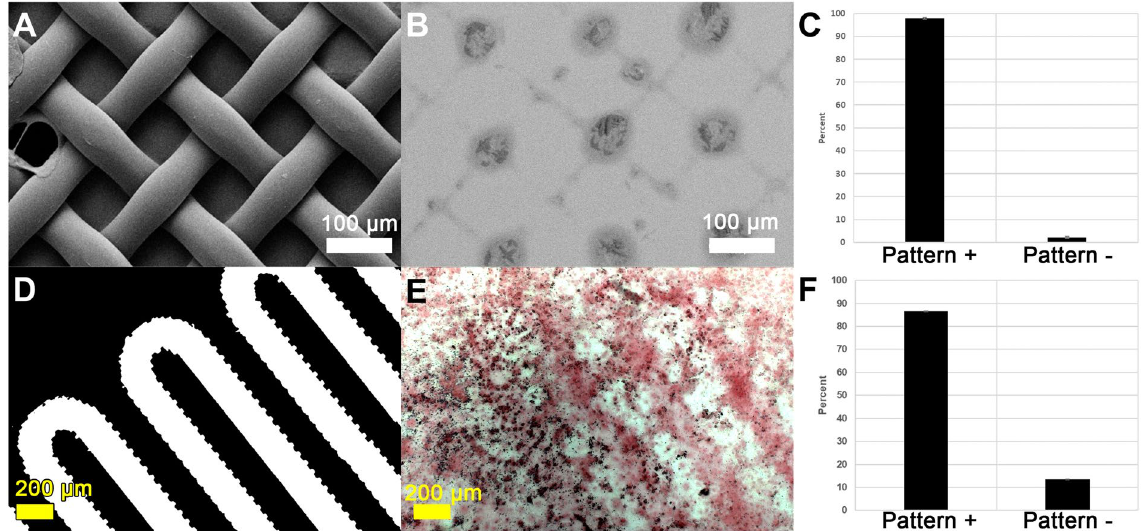
Figure 1. Patterned acellular ( A – C ) and osteoblast-directed mineralization ( D – F ) in response to PEG-WSM patterned substrates. ( A , D ) Photomasks, ( B , E ) resulting red-stained calcium mineralization and darker mineral nodules, ( C , F ) quantified mineralization that was contiguous with